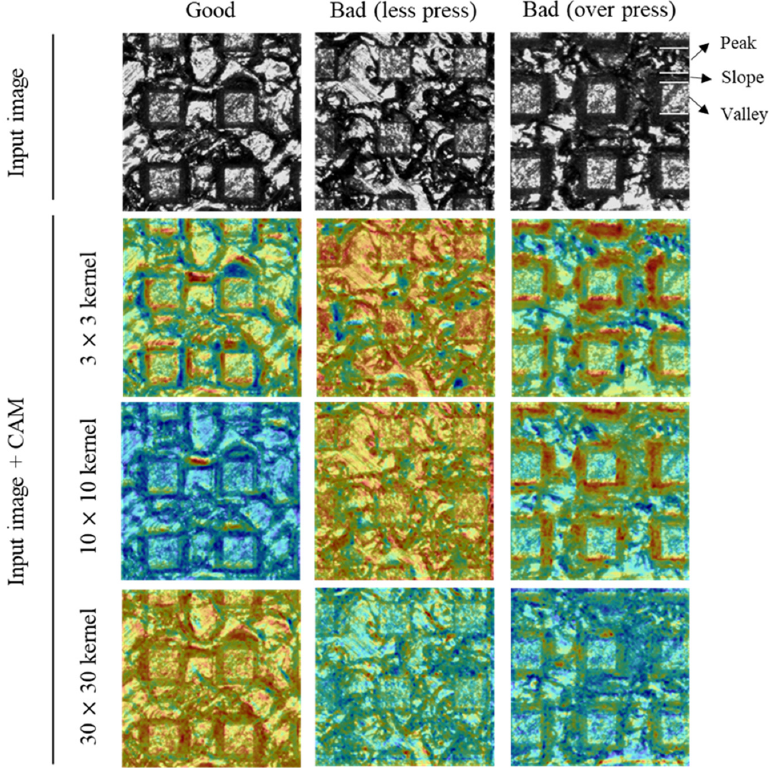
Figure 10. Changes in regions considered important in determining CNN according to the kernel size at 1st layer.